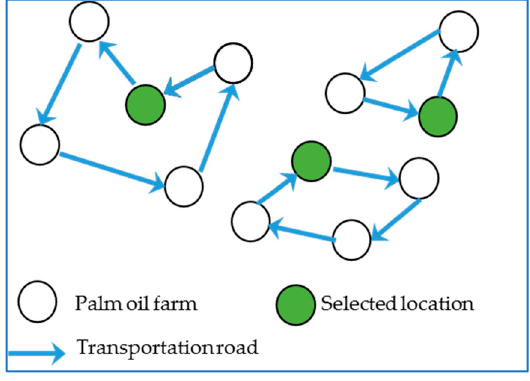
Figure 1. Problem Figure 1. Problem framework.